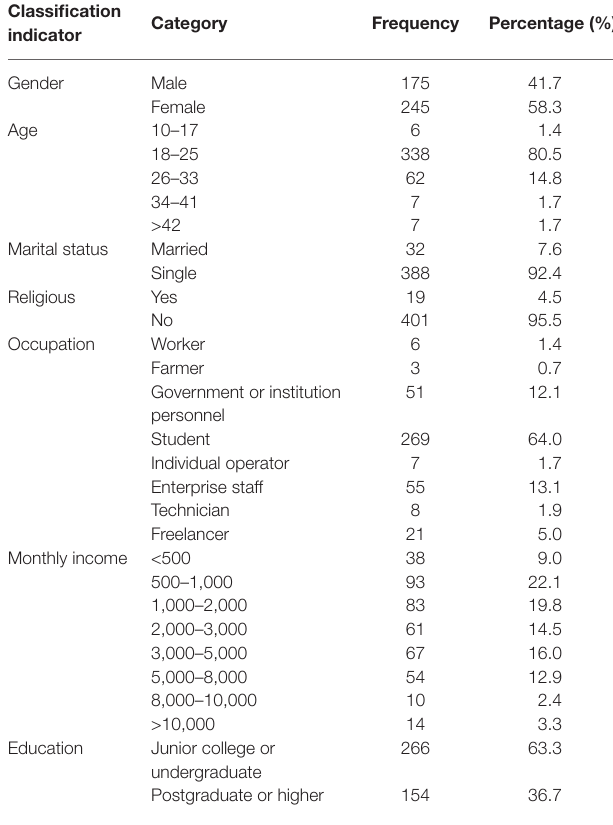
TABLE 1 | Characteristics of the survey